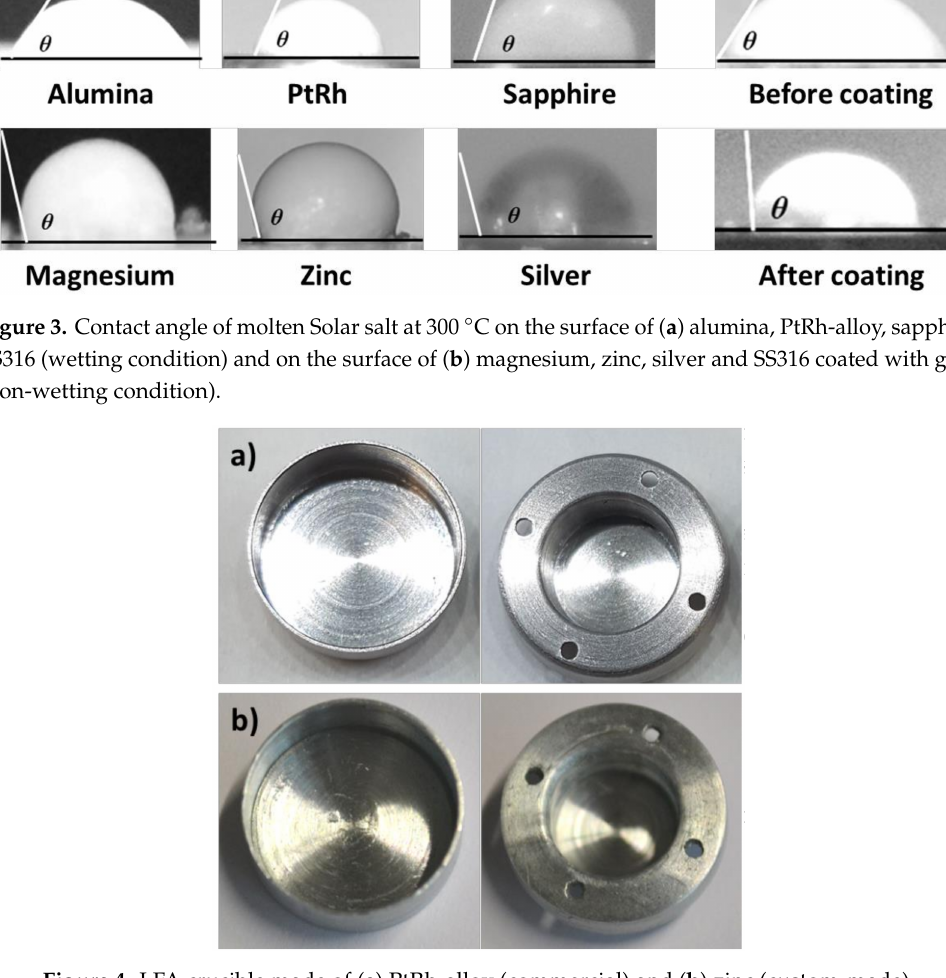
Figure 4. LFA crucible made of ( a ) PtRh-alloy (commercial) and ( b ) zinc